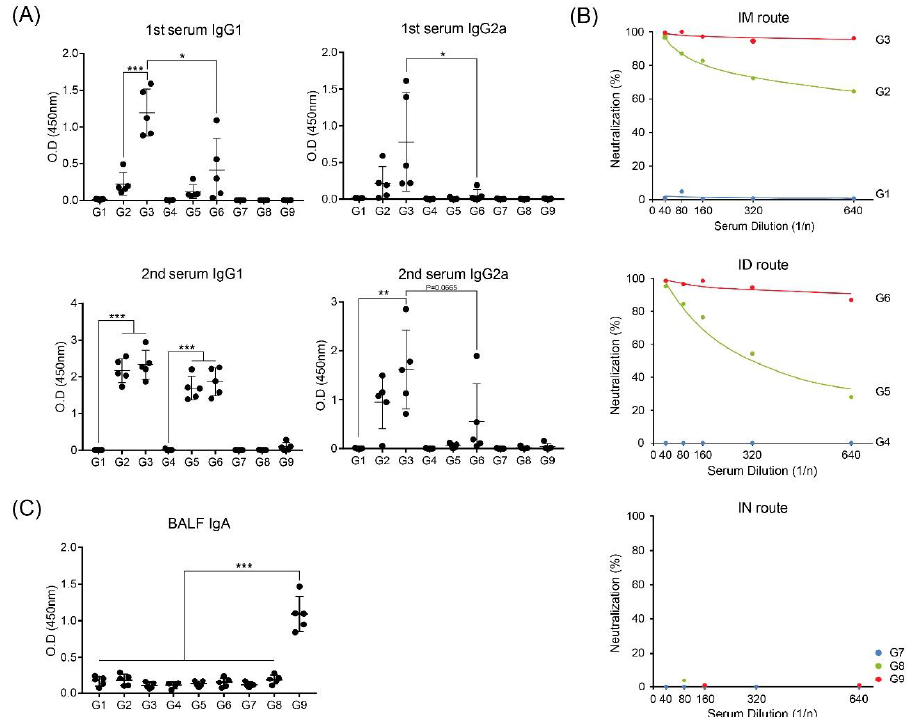
Figure 2. Immunization of RNA adjuvant with MERS S protein induces a humoral immune response. ( A ) MERS S protein-specific IgG1 and IgG2a levels were measured by ELISA. Serum was collected two and four weeks after first immunization. ( B ) MERS-CoV-specific neutralizing antibody (NAb) was determined by plaque-reduction neutralizing assay. Serum was collected two weeks after the second immunization, and each serum was pooled ( n = 5) and serially diluted from 1 / 40 to 1 / 640. ( C ) MERS S protein-specific IgA levels were measured by ELISA in bronchoalveolar lavage fluid (BALF). BALF